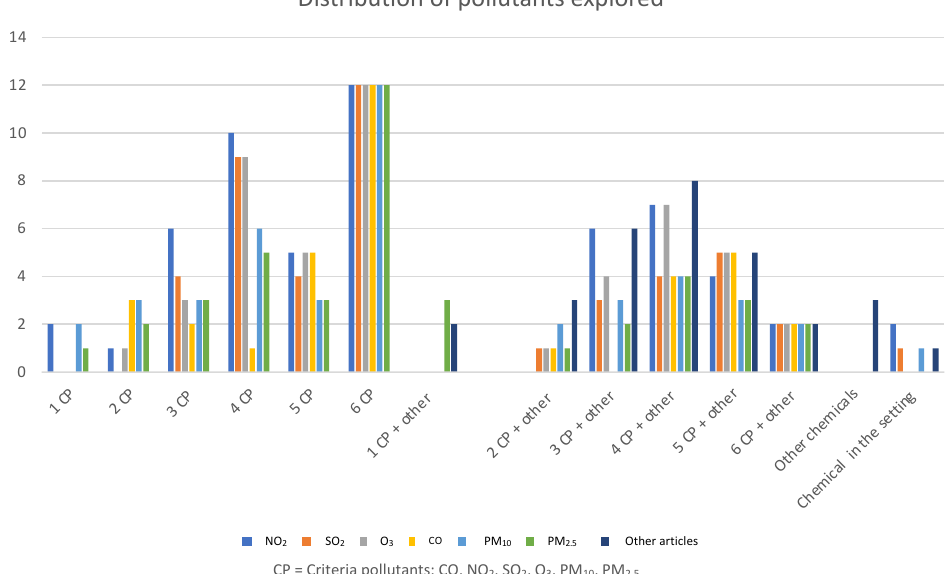
Figure 2. Distribution of the various pollutants studied in relation to health outcomes. 1 CP = the number of papers which explored one type of criteria pollutant. 2 CP–6 CP = the number of papers that explored multiple combinations of 2–6 criteria pollutants. Other = pollutants explored other than criteria pollutants including: Black carbon, black smoke, NO, NOx, NO 3 , SO 4 , sulphate H2S PAHs, COH, trace elements (copper, zinc, bromine, lead, iron, silicon, calcium, manganese, nickel, vanadium, selenium, sulphur, and potassium), volatile organic compounds (VOCs) (formaldehyde, benzene, toluene, methyl tert-butyl ether (MTBE)), particles, PNC (particulate number concentration/UFP indicator) or UFP, Delta-C, PM 2.5–10 , PN (particulate number), PNam (accumulation mode particle number), PM 2.5 bound hopanes, PMion (sum of sulphate nitrate and ammonium), PMrest (the difference between urban PM 10 and rural; a proxy for locally generated PM 10 ), PM 2.5 components, PM <2.5 , AMP (accumulation